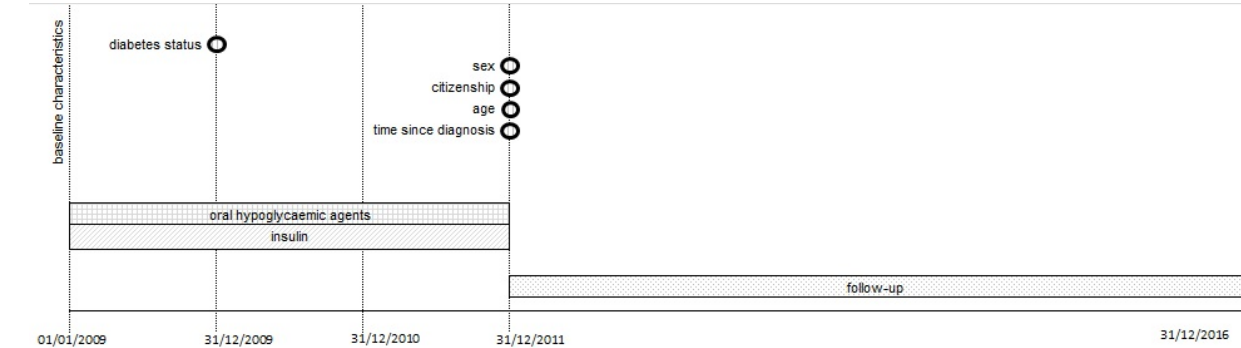
Figure 1. Study timeline showing the exposure assessment follow up periods. To minimize this bias, we also compared only T2DM patients exposed to insulin (alone or in any combination) with those on diet-only regimen during the same period.